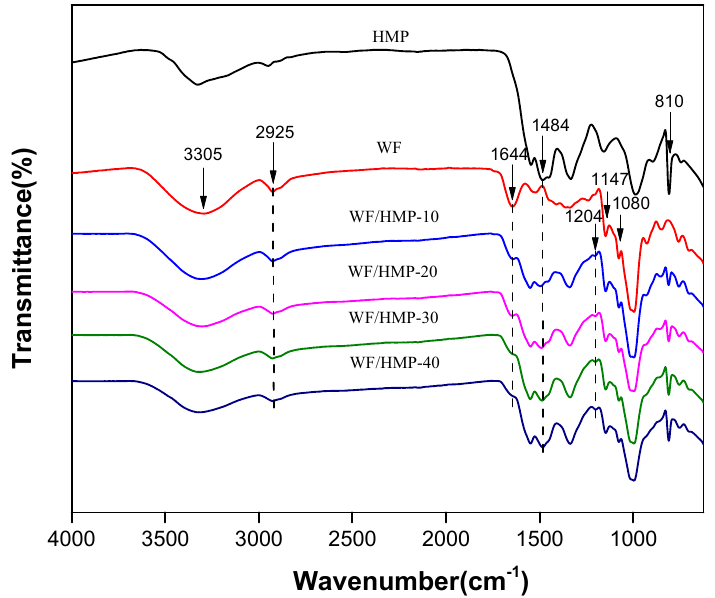
Figure 2. FTIR spectra of the different adhesive samples.